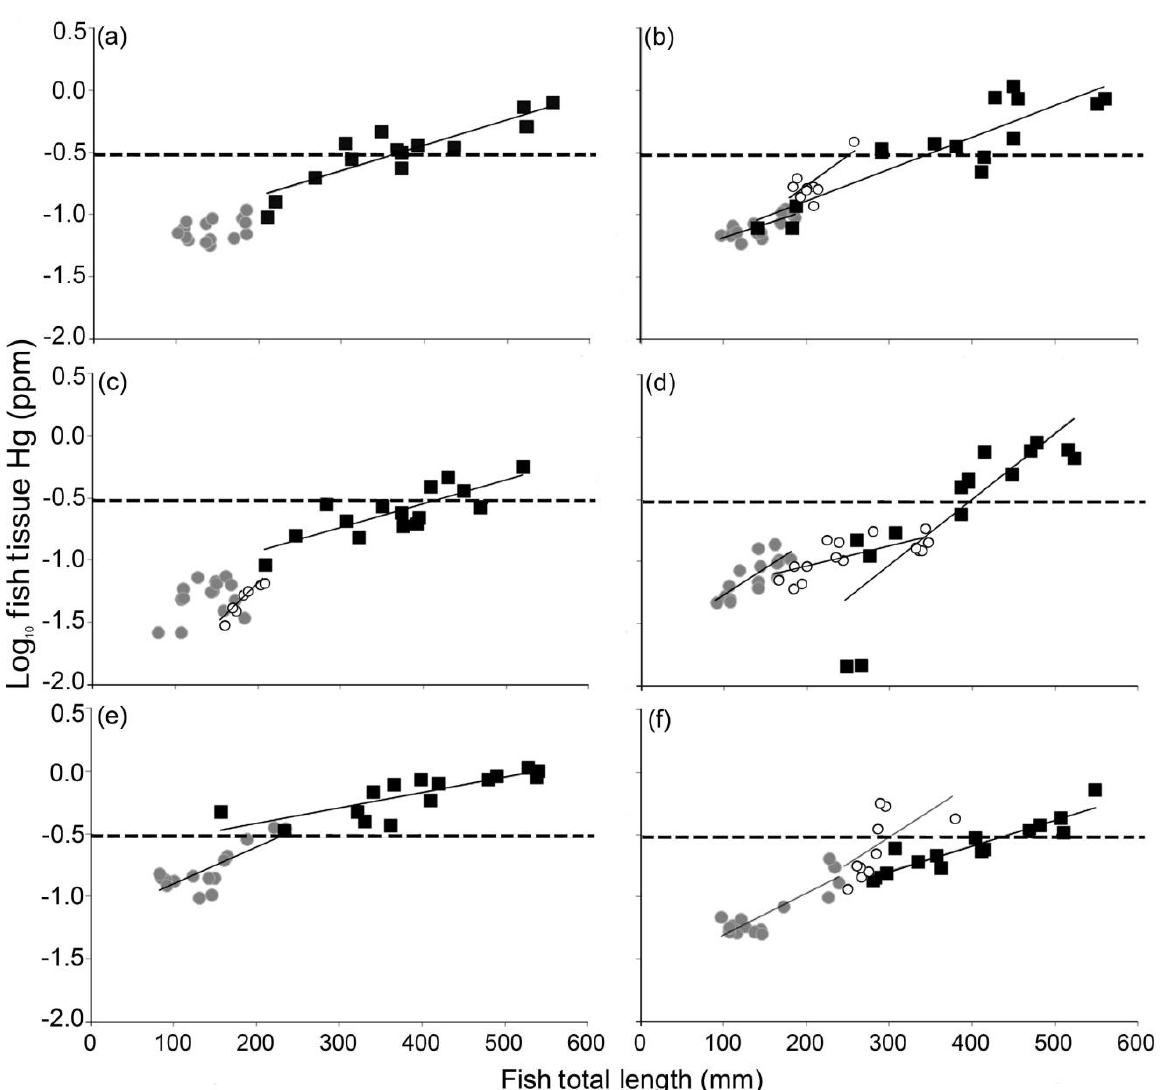
Figure 4. Regressions of log fish tissue Hg (ppm) on fish total length (mm) for bluegill 10 (light grey circles), black crappie (open circles) and largemouth bass (dark squares) in lakes ( a ) Adger, ( b ) Buckhorn, ( c ) Bennett‘s Millpond, ( d ) Mackintosh, ( e ) White, and ( f ) Waterville in North Carolina, USA. Solid lines represent regression equations for each species in each lake, except bluegill in Lake Adger and Bennett‘s Millpond, which did not have a significant relationship (see Table 2). The horizontal dashed lines indicate the USEPA Hg screening level of 0.3